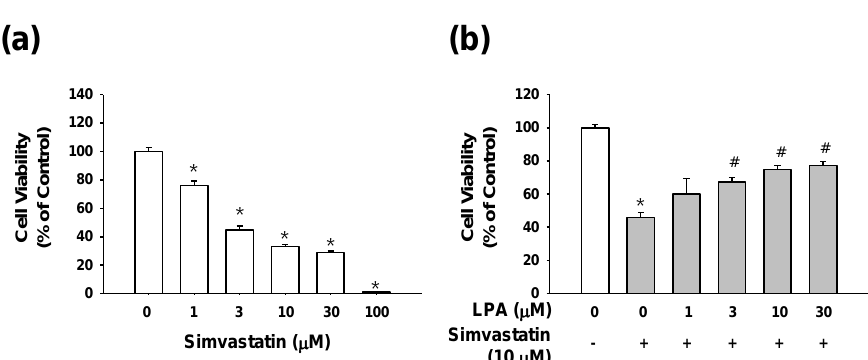
Figure 1. Effect of lysophosphatidic acid on viability of simvastatin-treated L6 cells. ( a ) Effect of simvastatin on L6 cell viability. Cells were incubated with simvastatin (1 –100 μM) in serum free medium for 48 h. ( b ) Effect of lysophosphatidic acid (LPA) on L6 cell viability in the prescence of simvastatin. L6 cells were treated with LPA (1 –30 μM) in the presence of simvastatin (10 μM) for 48 h. Cell viability was analyzed using an XTT assay. Cell viability level of untreated control was considered as 100%. Data represent the means ± SEM (n = 6). * p < 0.05 vs. untreated control; # p < 0.05 vs. simvastatin alone.